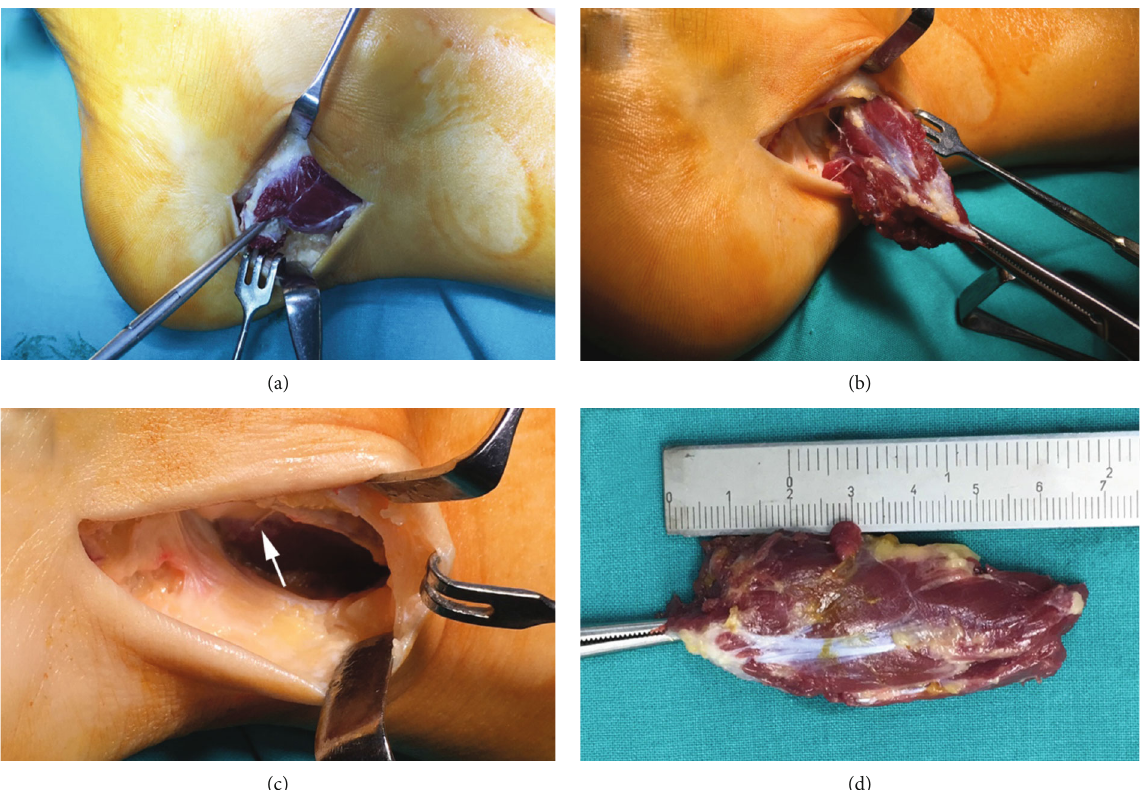
Figure 2: Intraoperative images of the patient presented in the fi rst case. (a) Incision was made just medial to the Achilles tendon proximally and extended down to the proximal border of the tarsal tunnel. Accessory soleus muscle (ASM) is visible right below the skin and subcutaneous tissue. (b) ASM was bluntly dissected and separated from the surrounding structures. (c) Neurovascular bundle of the posteromedial part of the ankle is visualized. Neurovascular bundle is pointed by a white arrow. (d) The completely resected muscle that is approximately 7cm long. A muscular distal portion is marked by a Kocher ’ s